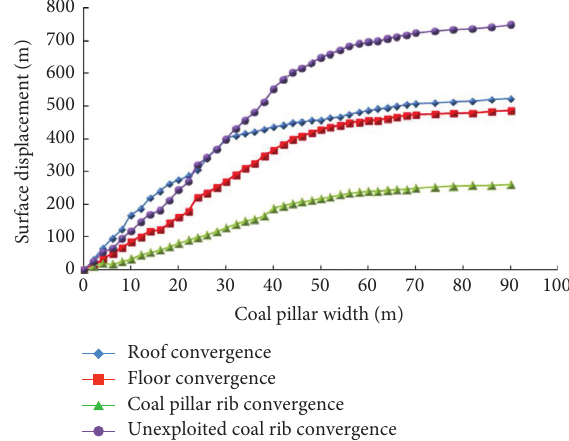
Figure 13: Surface displacement curve of the #2 station during the roadway driving